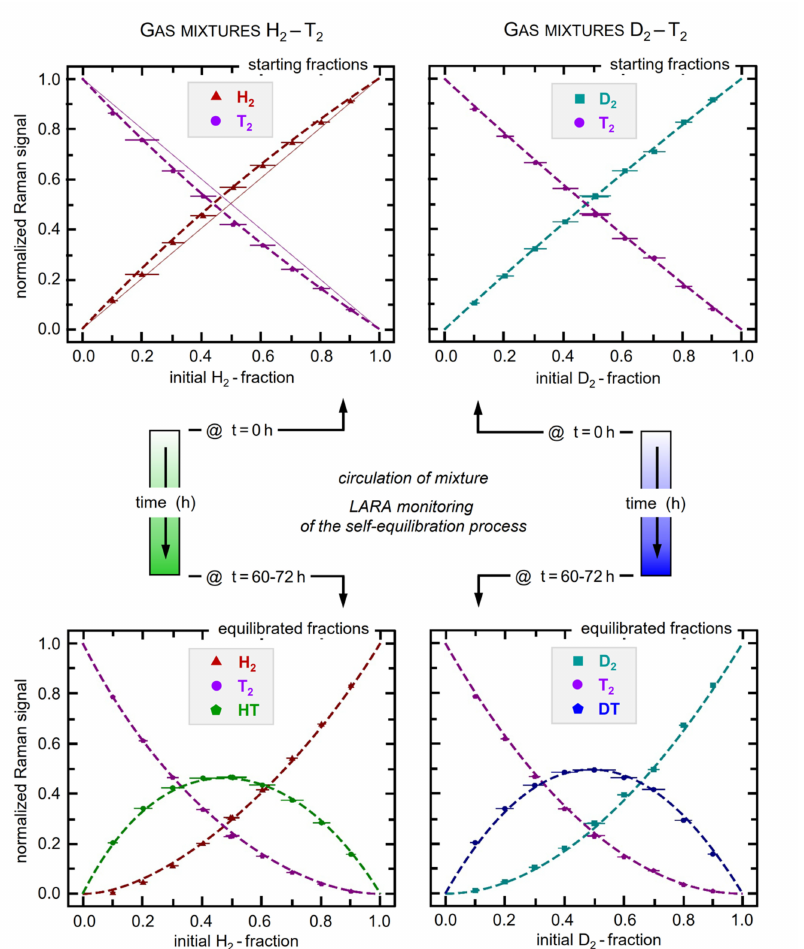
Figure 7. Calibration curves for gas mixtures of H 2 -T 2 and D 2 -T 2 (spectral sensitivity corrections and transition probability factors are incorporated in the relative Raman signals). All error bars (1 σ ) are expanded by a factor of × 5 in the display, for better visibility. Note that the top and bottom panels relate to the data of the initial mixture at t = 0 h and after full equilibration at t > 60 h, respectively. As an example, the straight-line curves for a hypothetical, theoretical intensity relation of R XY = 1 were added for the initial H 2 -T 2 mixtures (top left panel). For further details, see